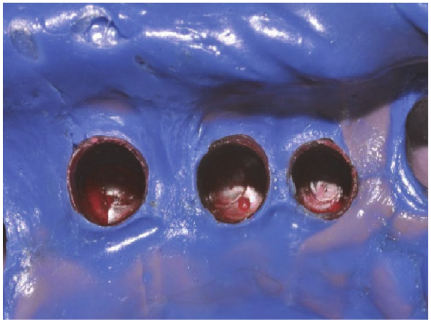
Figure 17: Details of superior final impression.